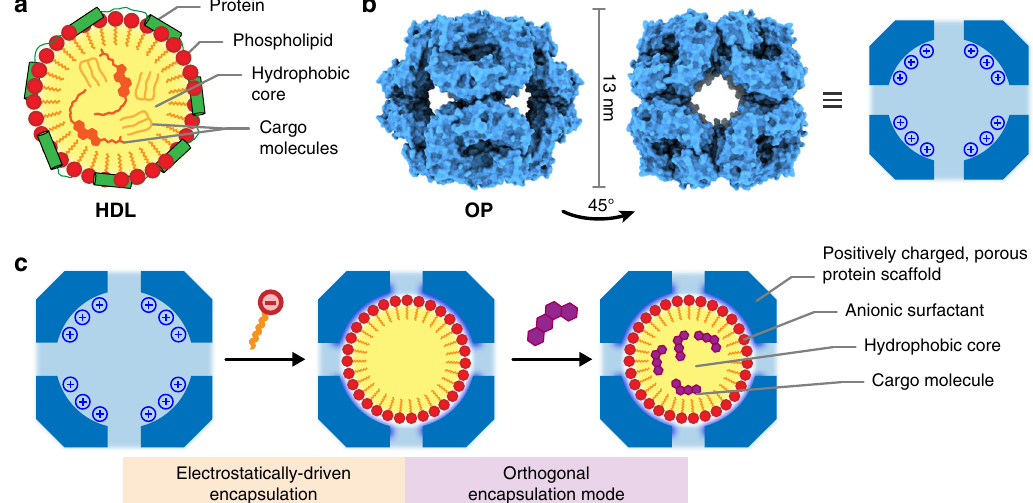
Fig. 1 Self-assembly of lipoprotein-mimetic capsids. a Cartoon depiction of a high-density lipoprotein (HDL) particle, showing the charged phospholipids, proteins, and hydrophobic cargo molecules. b Surface representations of the OP protein cage viewed along the twofold (left) and fourfold (right) symmetry axes and a cartoon cut-away depicting the positively charged interior. c Two-tier encapsulation concept: electrostatic attraction drives the encapsulation of anionic surfactants, which phase separate due to their high effective concentration, forming micellar aggregates within OP cages. The hydrocarbon core of these stable protein – surfactant complexes then sequesters nonpolar small molecules by means of the hydrophobic